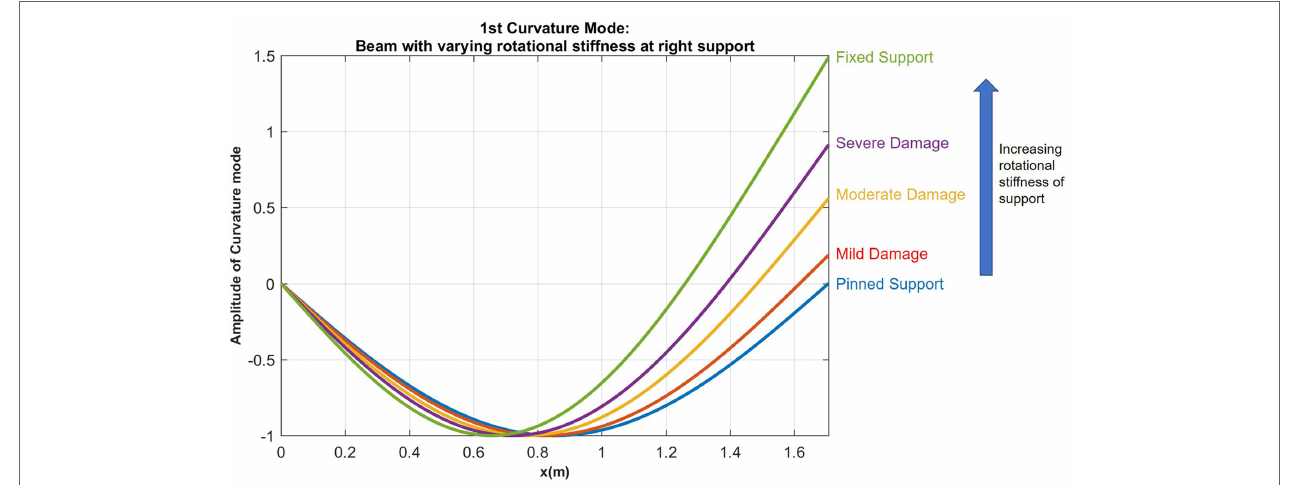
FIGURE 5 | Case study: curvature of beam with varying rotational stiffness at support.